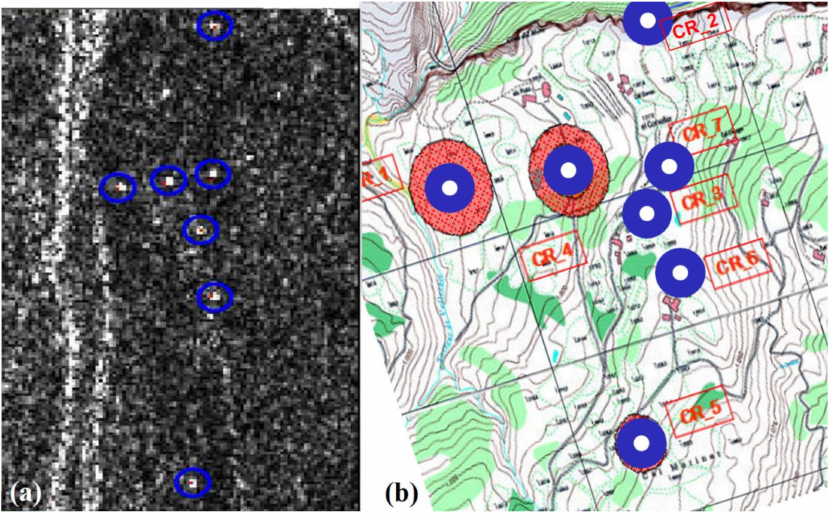
Figure 16. ( a ) the 7 Corner Reflectors appear as bright spots in a 2007 radar amplitude image; ( b ) the concentric circles on the map represent the rate of movement of the CRs during the first half of 2007.